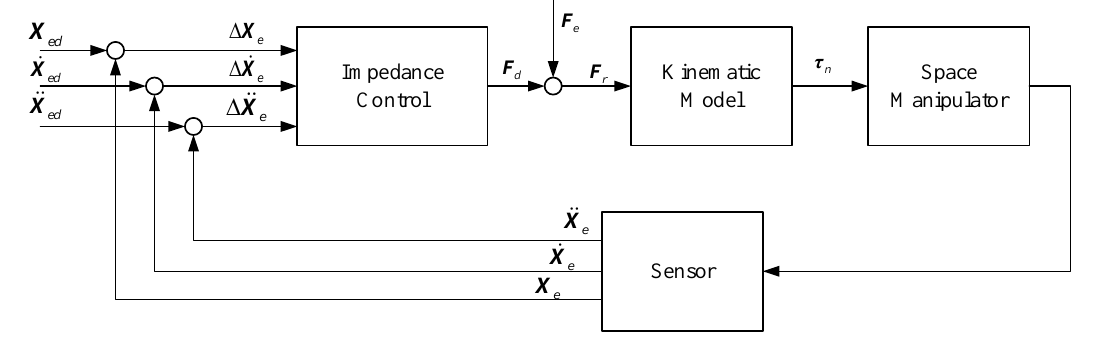
Figure 5. The position-based impedance control schematic.